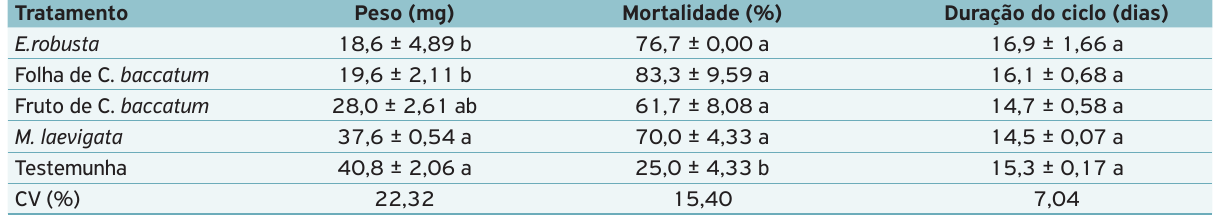
Dados originais apresentados. Para análise estatística os dados foram transformados em arcsen. Médias (± erro padrão) seguidas pela mesma letra na coluna não diferem entre si, pelo teste de Tukey (p < 0,05).